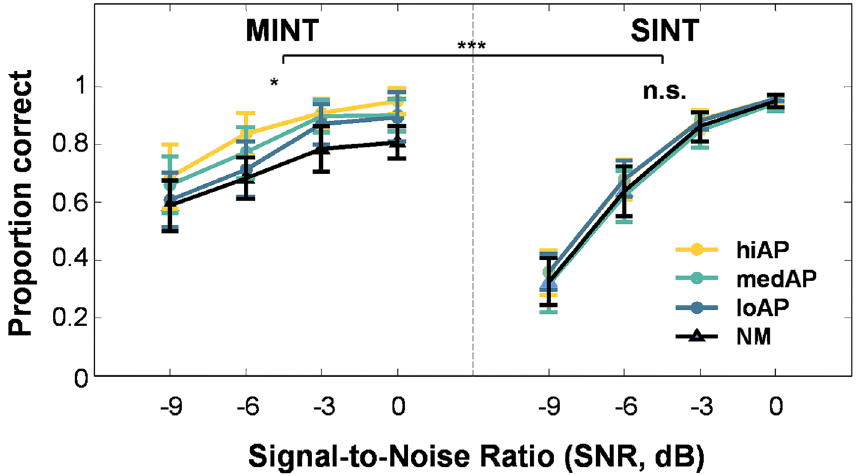
Figure 3. Mean performance accuracy on music-in-noise and speech-in-noise tasks as a function of SNR and quasi-AP proficiency level. Different-colored lines indicate different levels of quasi-AP ability. Error bars represents ± 1 SD. ***p < 0.001, **p < 0.01, *p < 0.05 level of significance; ns not